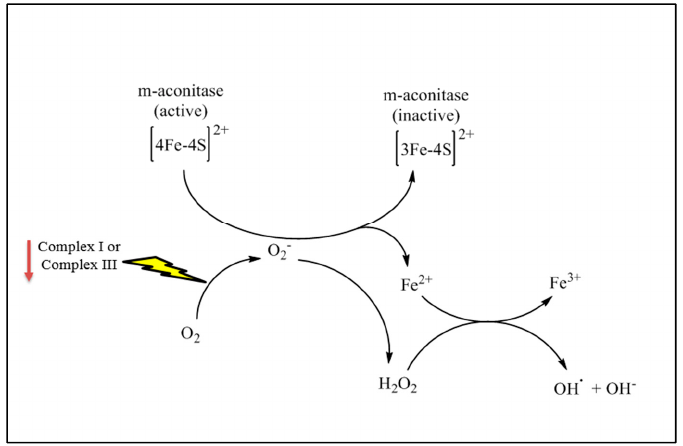
Figure 1. A schematic underlies the pathway of mitochondrial free radical generation and Figure 2. A potential mechanism for the oxidative inactivation of m-aconitase by mitochondrial O • ̄ 2 .